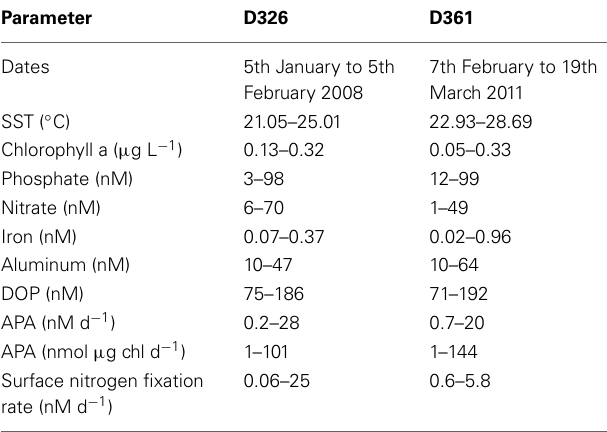
Table 2 | Range in surface ocean properties, concentrations of inorganic and organic nutrients (nM), trace metals (nM), chlorophyll a ( µ g L − 1 ), rates of alkaline phosphatase activity (APA,nM d − 1 ) and nitrogen fixation (nM d − 1 ) during cruises D326 and D361.